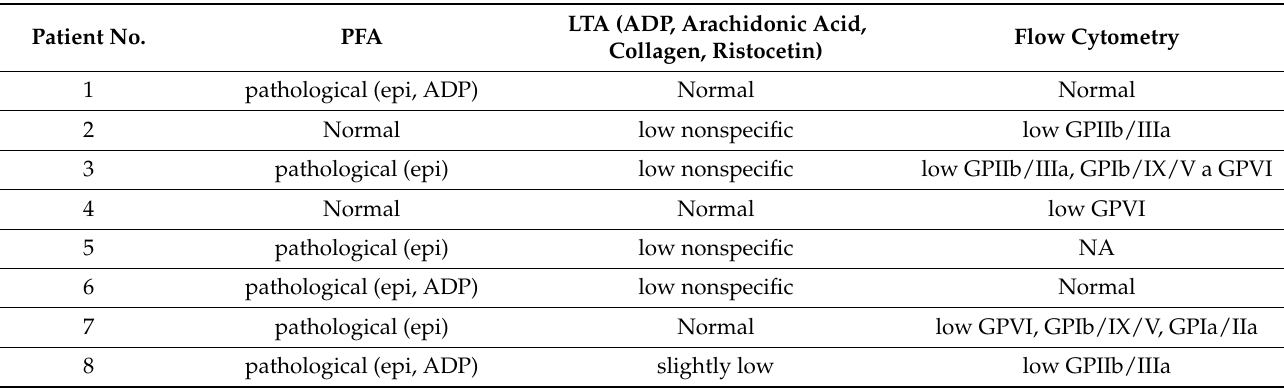
Table 2. Results of platelet function